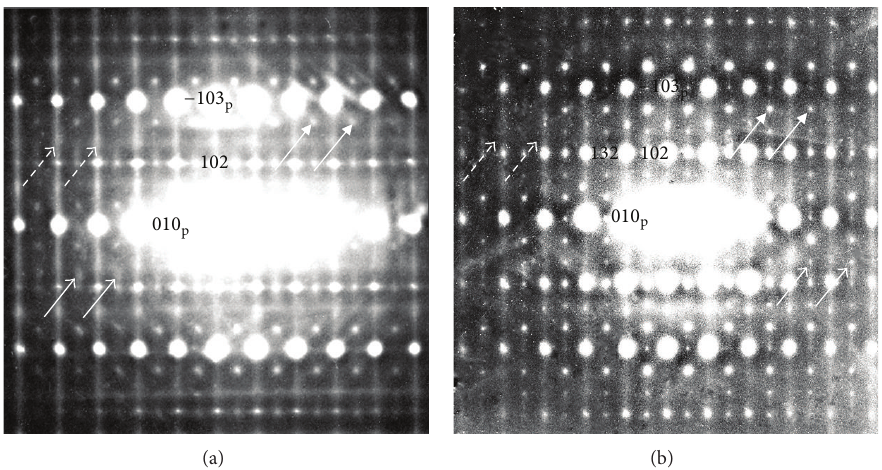
Figure 2: Electron diffraction patterns along a − 3, 0, −1